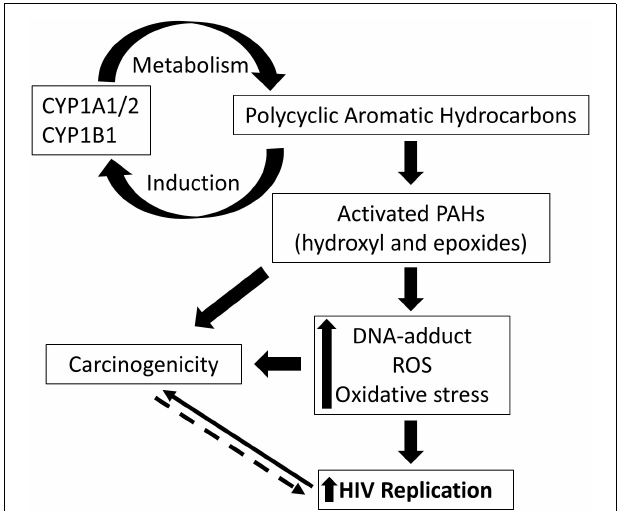
FIGURE 1 | Schematic representation of the cytochrome P450 (CYP)-mediated effects of polycyclic aromatic hydrocarbons (PAHs) on HIV pathogenesis. PAHs are known inducers of CYP1A1/1A2/1B1 and these CYP enzymes are responsible for metabolism and activation of PAHs. Activated PAHs and oxidized metabolites mediate increased production of reactive oxygen species, oxidative stress, and DNA-adduct formation. These cellular changes, in turn, are known to enhance HIV replication and mediate carcinogenicity. Increased ROS production, on the other hand, in tumor cells due to mitochondrial dysfunctioning, for instance, can be rationalized to facilitate HIV replication. Targeting the overexpressed CYP 1 enzymes, therefore, serves as a rational clinical approach to impact the incidence of cancer and viral replication in HIV positive smokers.